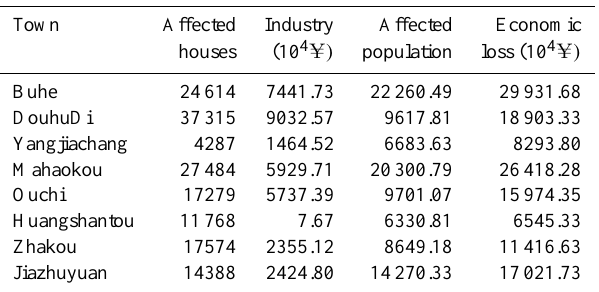
Table 3. The result of the quantitative flood damage estimation